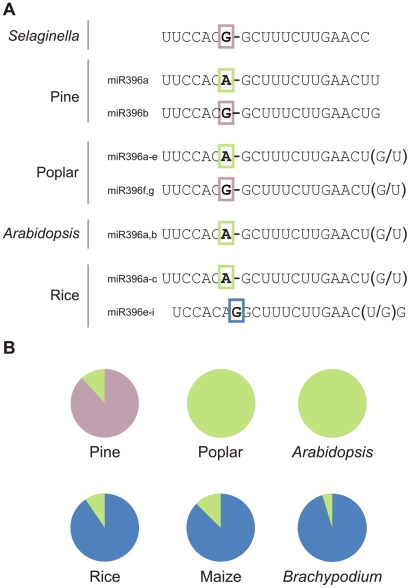
Variations among miR396 family members in plants.(A) MiR396 family composition of selected species. Differences in the 5′ region are highlighted with colored boxes, while variations at the 3′ end for each case are indicated in parentheses. (B) Diagrams showing the relative abundance of miR396 variants in pine, poplar, Arabidopsis and monocot libraries according to deep sequencing data (see Table S5).